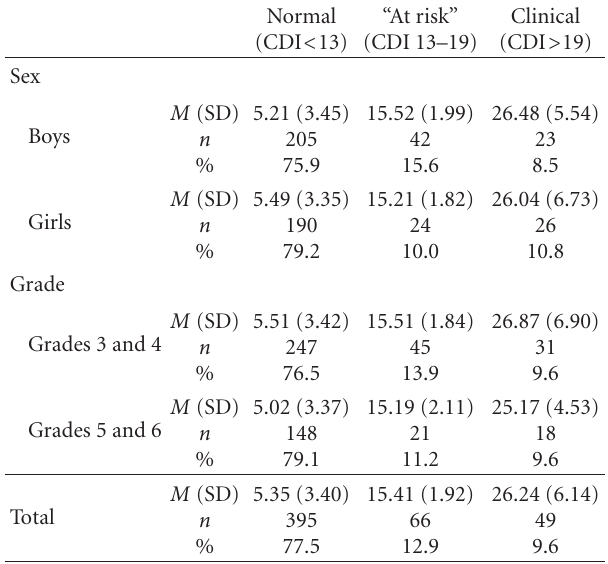
Table 2: Number of participants falling within the normal, “at- risk”, and clinical range of depressive symptoms and the mean level of depressive symptoms across sex and